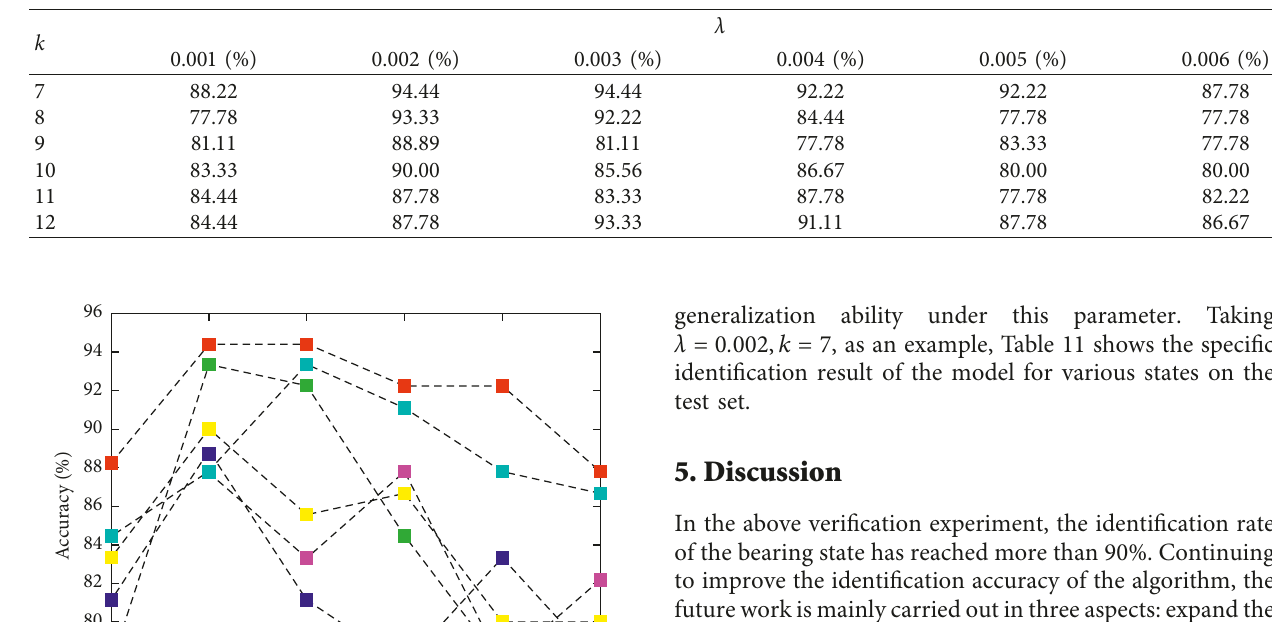
Table 9: Cross-validation set identification rate.